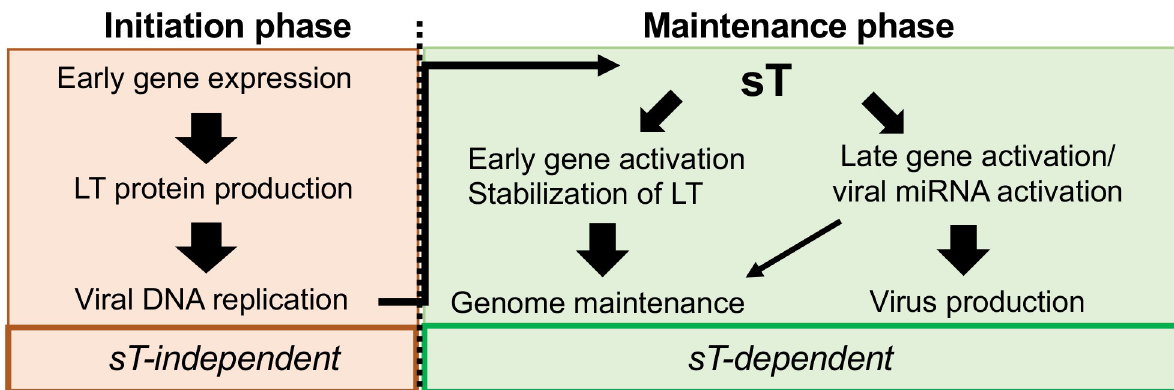
Fig 10. Importance of two MCV replication phases for sT function. Replication initiation phase, including early gene expression, LT production, and initial viral origin replication, does not require sT function, but activates sT. In the maintenance phase of replication, sT regulates viral transcription targeting factors such as Cux1, c-Jun, and CBP as well as DNA replication by stabilizing LT [11]. Maintenance of LT stability and early gene expression may control genome maintenance. Late gene induction that results in viral capsid assembly progresses viral life cycle and may also control genome maintenance via viral miRNA expression